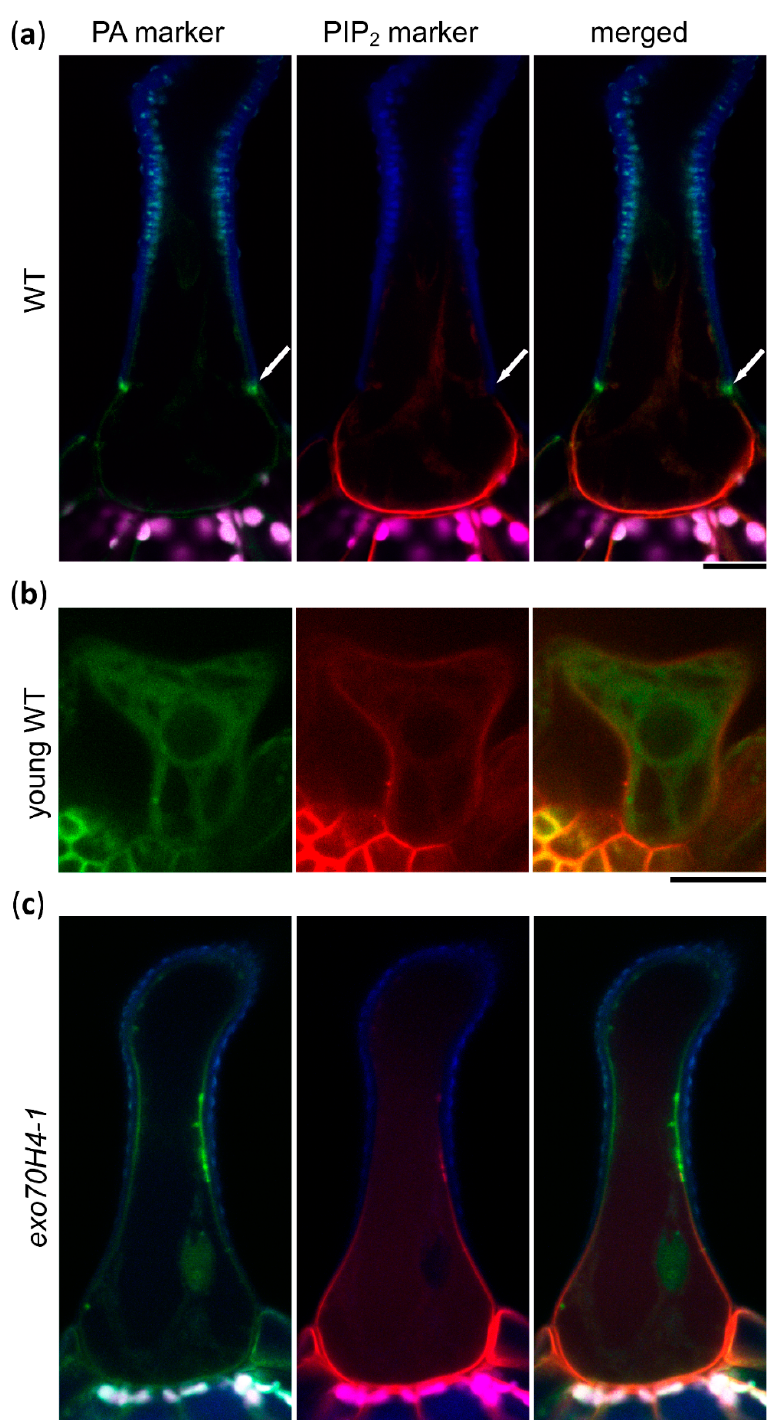
Figure 2. Lipid markers in WT and exo70H4-1 trichomes. ( a ) Colocalization of PA and PIP 2 markers in WT trichome; ( b ) colocalization of PA and PIP 2 markers in WT trichome in the elongation stage; ( c ) colocalization of PA and PIP 2 markers in an exo70H4-1 mutant background. Blue—cell wall autofluorescence; magenta—chlorophyll autofluorescence; green—YFP; red—mCherry. White arrows point at the Ortmannian ring. Scale bars = 20 µm.